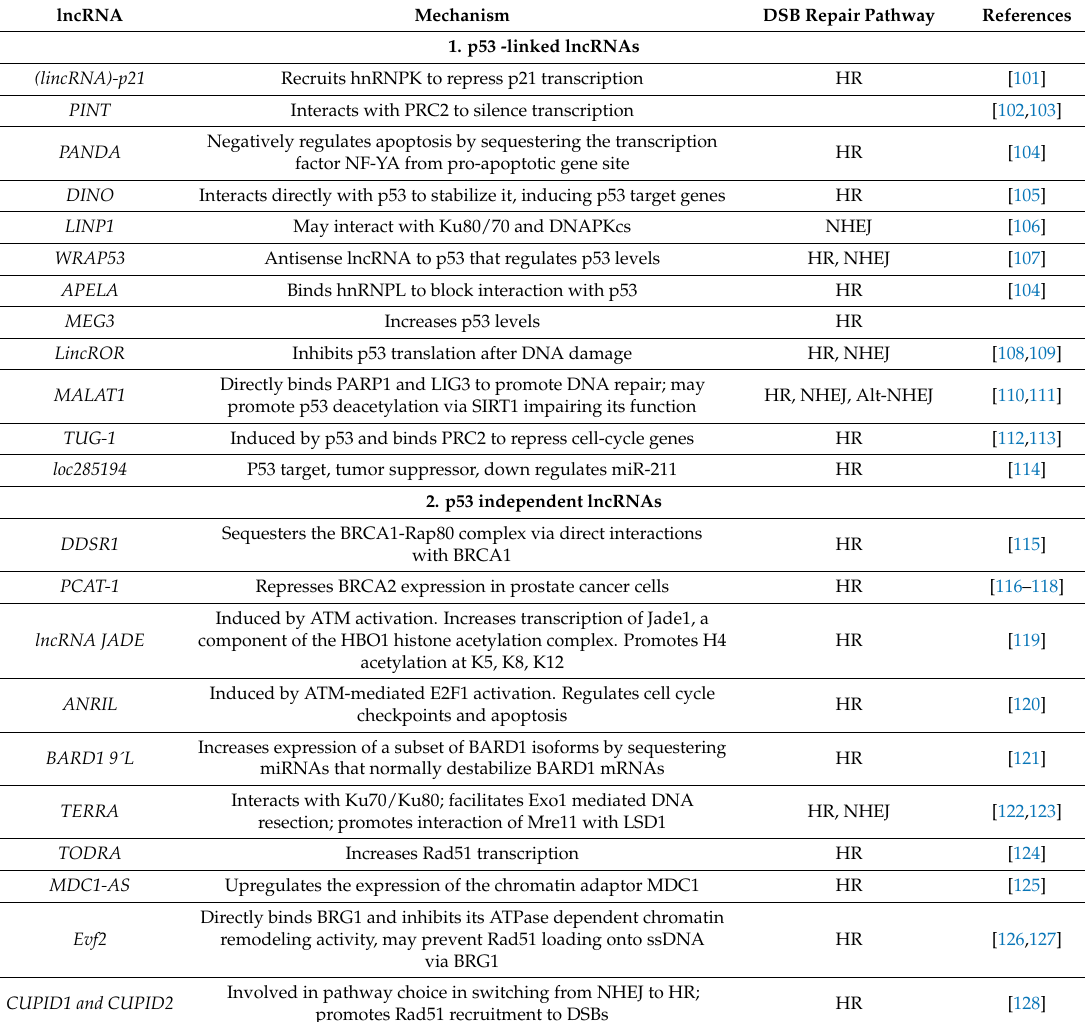
Table 1. LncRNAs involved in homologous recombination (HR) or non-homologous end joining